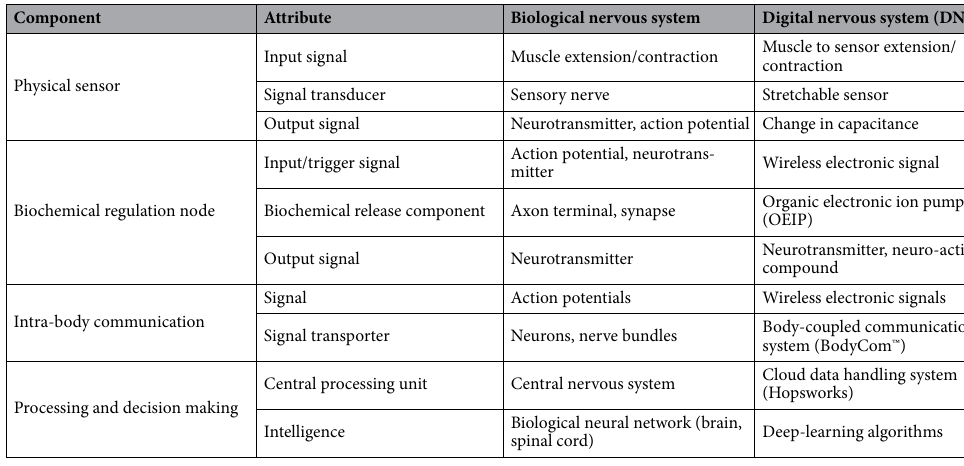
Table 1. Comparison of the digital nervous system (DNS) to the biological nervous